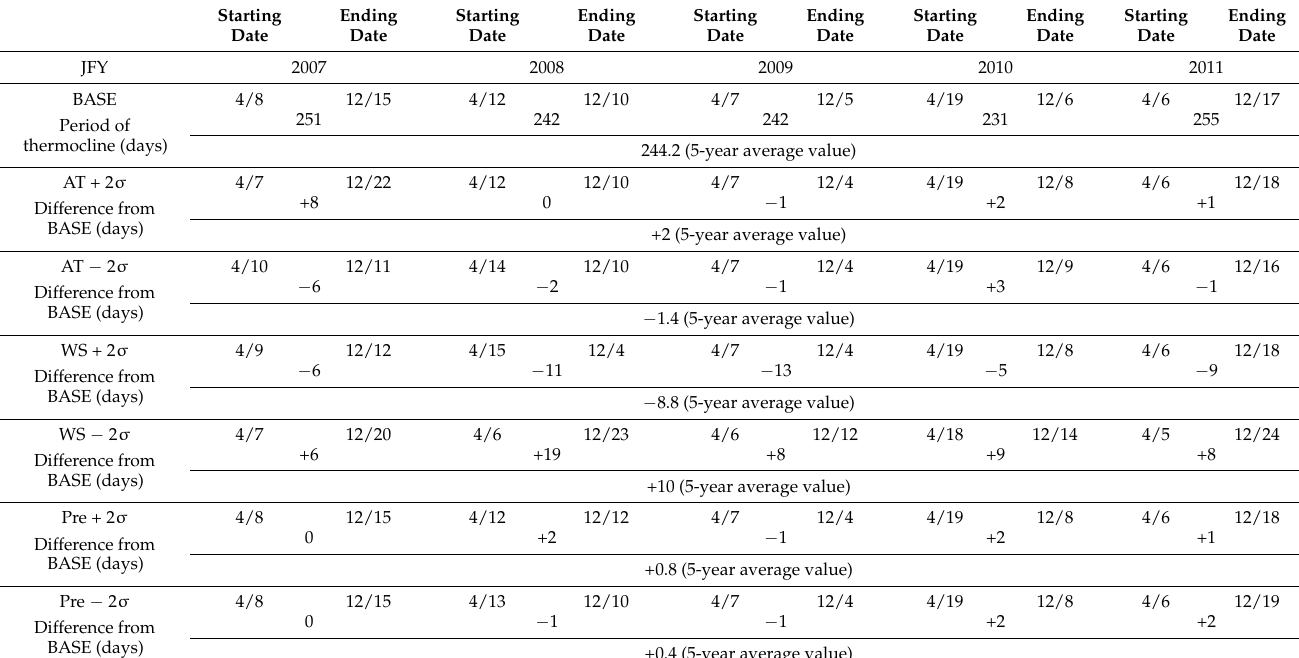
Table 3. Difference of the five-year average value of the period of thermocline, between each meteorological condition and